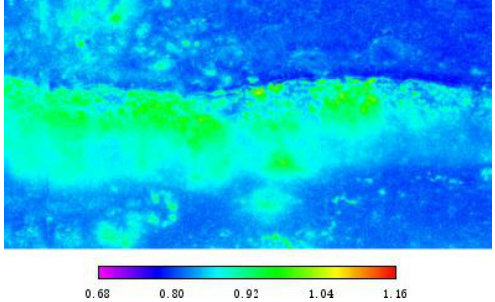
Figure 8. Reflectance spectra of northern cape of Crater Plato